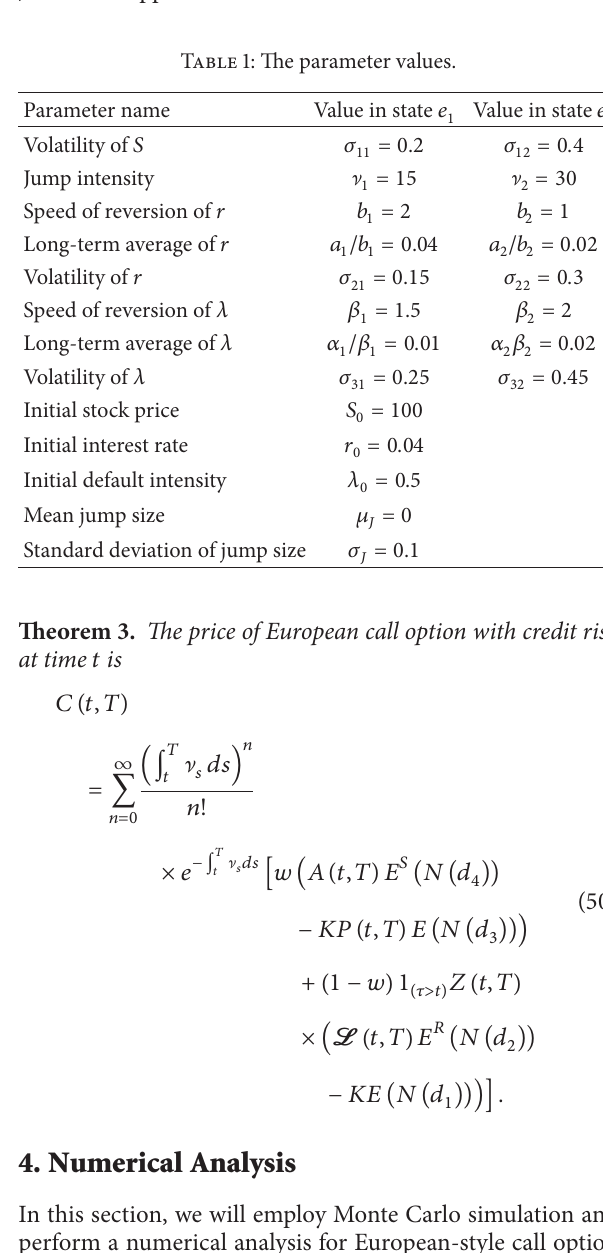
Figure 2: The option price with different maturity 𝑇 for 𝜔 = 0.4 , = 0.7 , 𝜌 = 0.5 , and 𝜌 = 0.6 𝜌 12 13 23